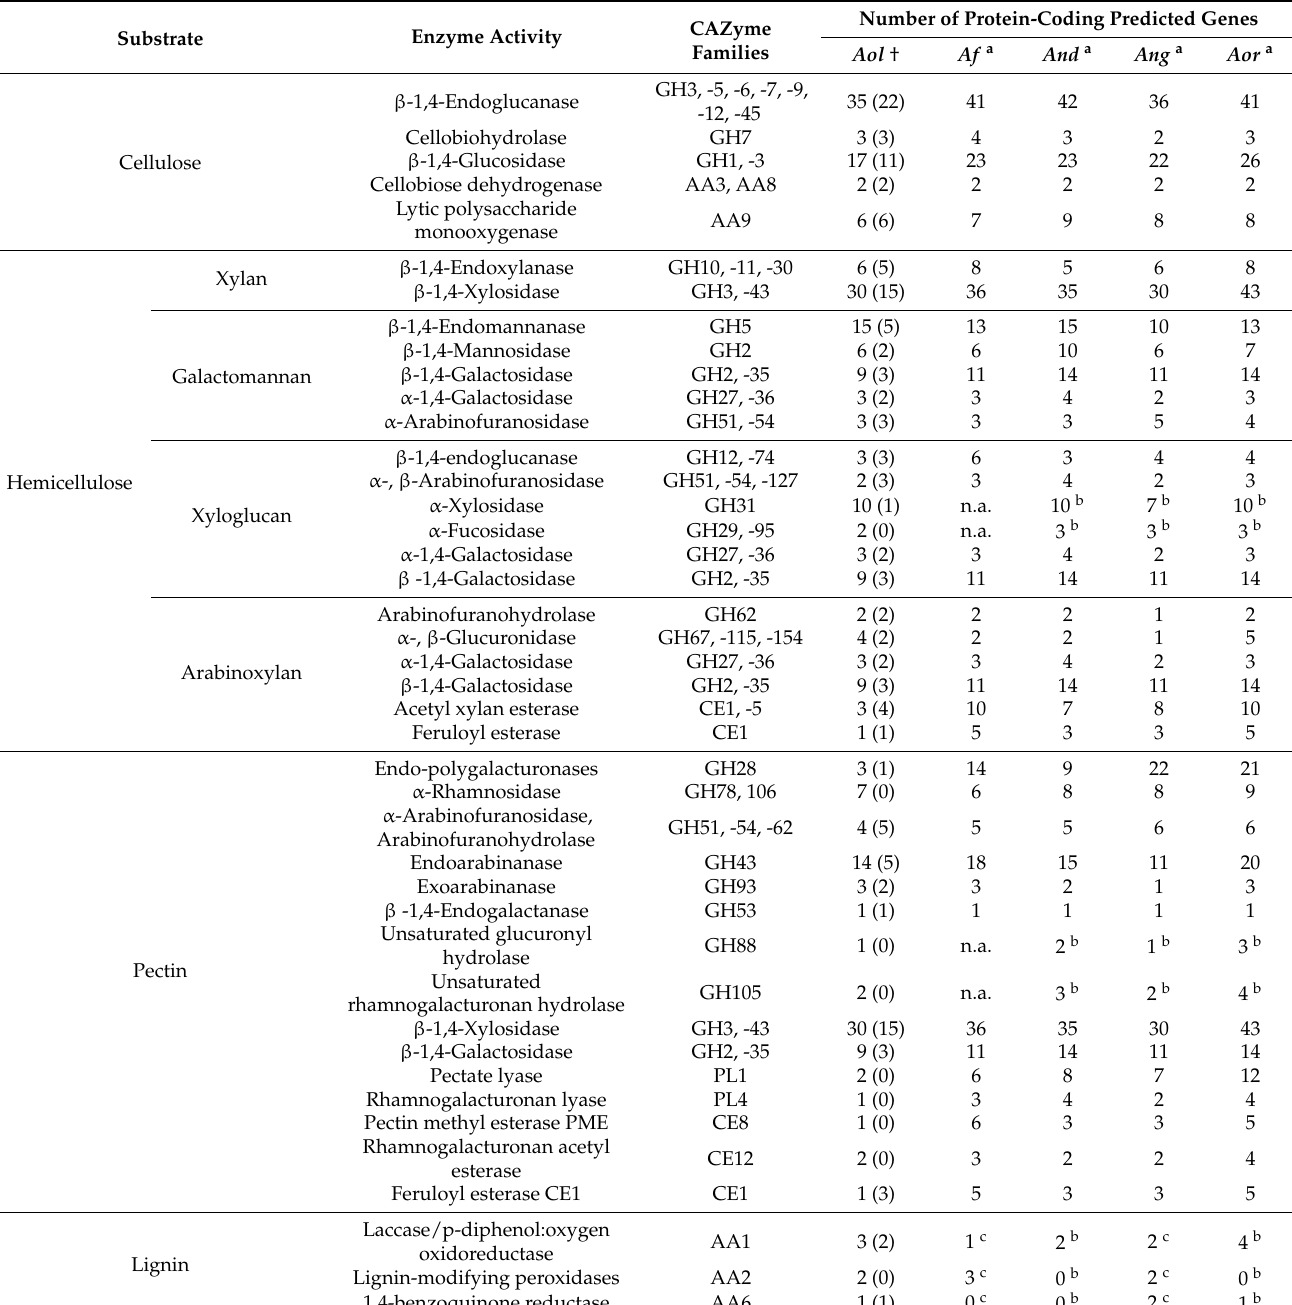
Table 4. Comparison of predicted number of glycosyl hydrolases (GH), carbohydrate esterases (CE), polysaccharide lyases (PL) and of auxiliary activities (AA) found in the genome of A. olivimuriae ( Aol ) (this work), A. fumigatus ( Af ), A. nidulans ( And ), A. niger ( Ang ) and A. oryzae ( Aor